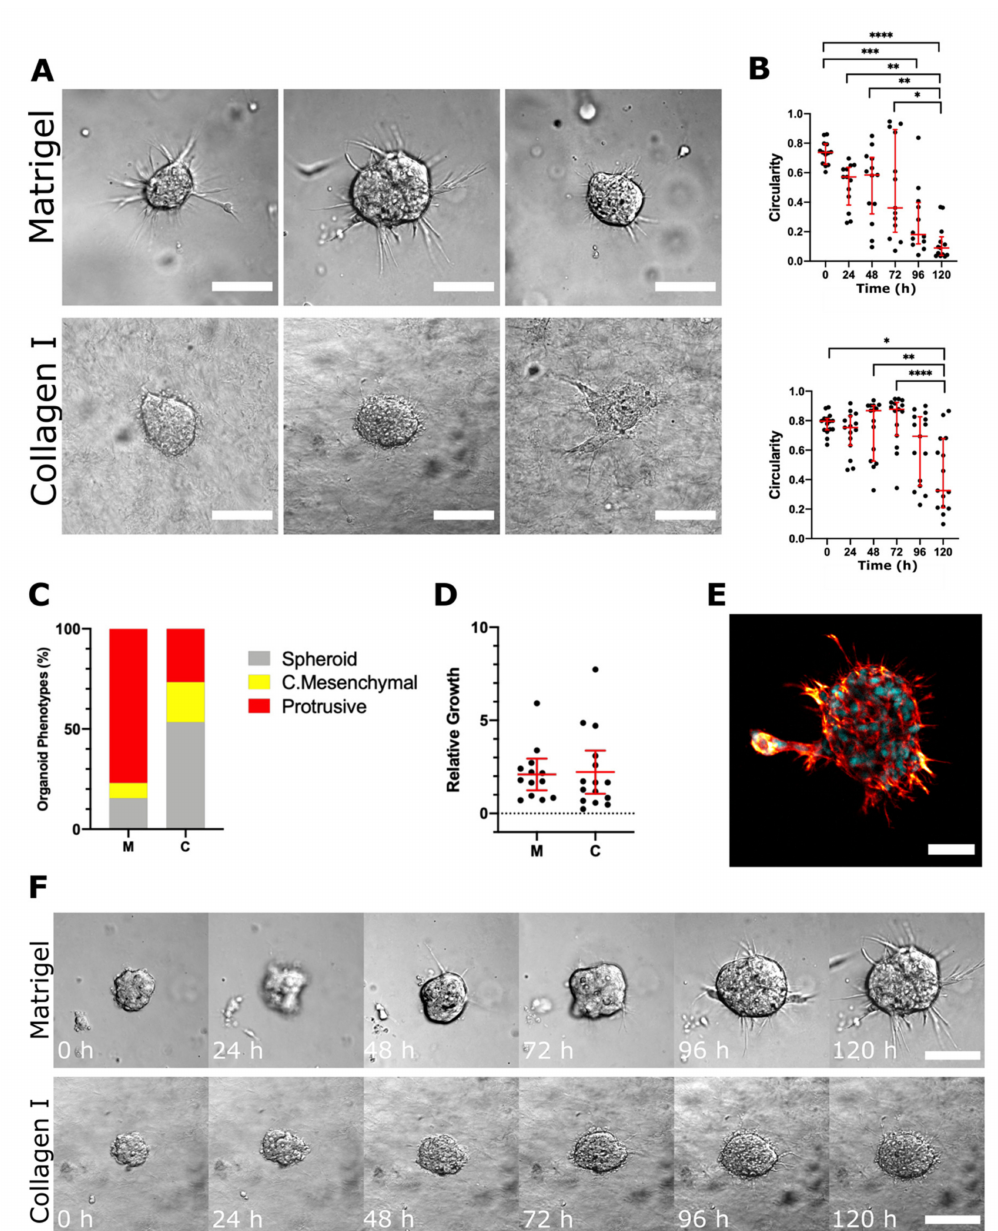
Figure 6. The invasive behaviour of SH-SY5Y cells is altered in response to an in vivo tumour microenvironment. ( A ) Rep- resentative DIC images of organoids isolated from SH-SY5Y xenografts after 5 days of culture in Matrigel and collagen. ( B ) Organoid circularity, where a value of 1.0 indicates a perfect circle, was measured to support microscopic observations of phenotypical changes in Matrigel and collagen (Kruskal–Wallis and Dunn’s post-hoc tests; horizontal bars represent median and interquartile range). ( C ) Bar charts represent the proportion of organoids per phenotype classification. ( D ) The rel- ative growth of organoids was calculated by dividing the difference in area between 0 h and 96 h by the area at 24 h (Brown–Forsythe ANOVA with T3 Dunnett post-hoc tests; horizontal bars represent mean ± 95% confidence intervals). ( E ) Representative confocal image of a “protrusive” SH-SY5Y organoid in Matrigel; nuclei stained with DAPI (cyan) and F-actin stained with phalloidin (red). ( F ) Representative DIC time-lapse images of protrusive invasion in Matrigel and collagen I over a 120 h period. In all plots, each dot represents one organoid ( n = 13 in Matrigel, n = 15 in collagen) and asterisks indicate statistical significance (* p < 0.05, ** p < 0.01, *** p < 0.001, **** p < 0.0001). DIC scale bars = 100 µ M, confocal scale bars = 50 µ